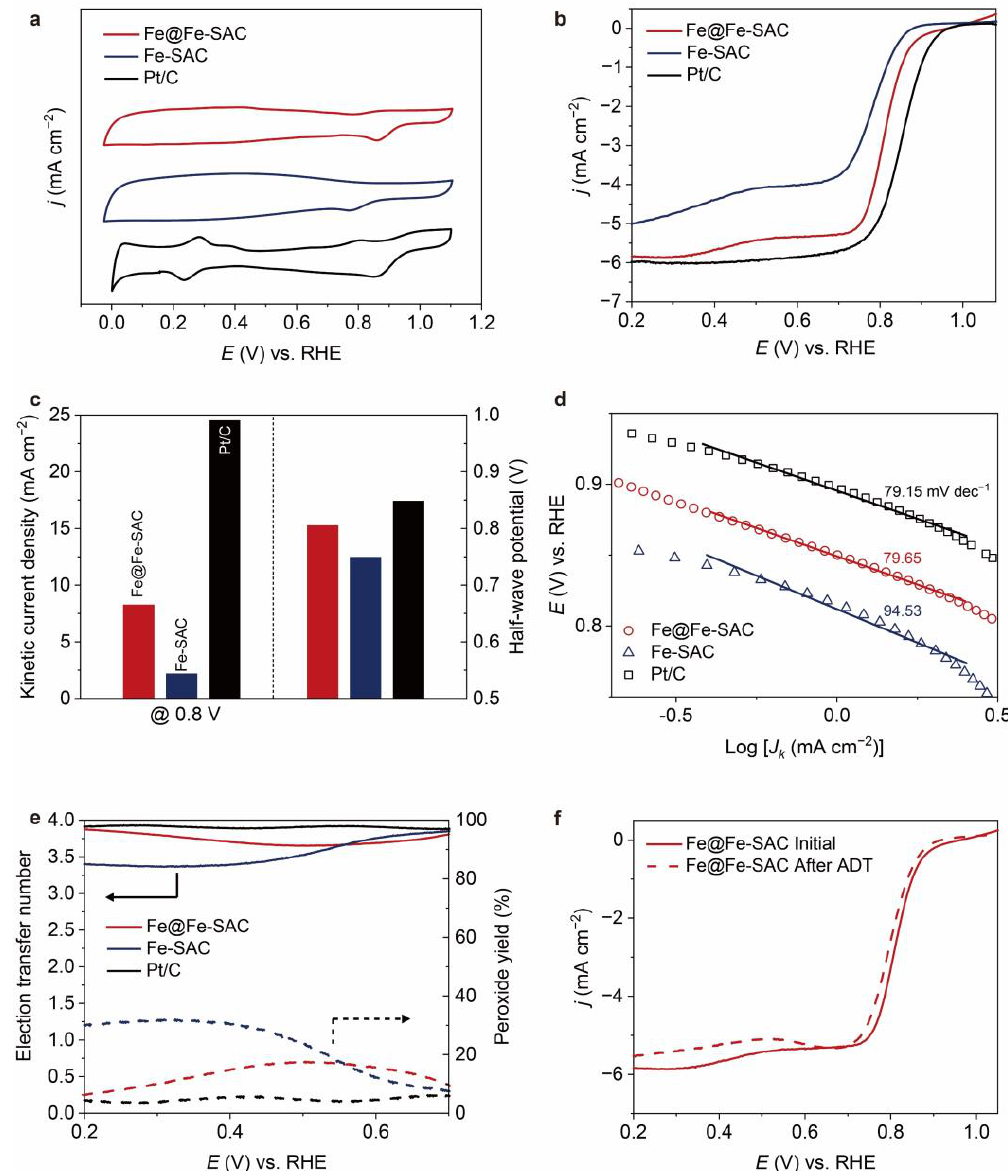
Figure 4. Electrocatalytic ORR performance of Fe@Fe-SAC. ( a ) Cyclic voltammetry curves recorded in an O 2 -saturated 0.1 M KOH solution. ( b ) Linear sweep voltammetry curves recorded in an O 2 -saturated 0.1 M KOH solution. ( c ) Kinetic current density and half-wave potential. ( d ) Tafel plots derived from ORR polarization curves. ( e ) Electron transfer number and peroxide yield plots. ( f ) LSV evolutions.